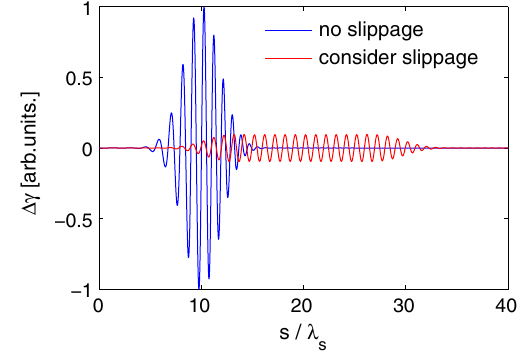
FIG. 1. Energy modulation with an ultrashort seed laser pulse. The energy modulation amplitude is uniform in the central part when considering the slippage effect using Eq. (7) (red line). For comparison, the energy modulation that directly copies the electric field is shown with a blue line.